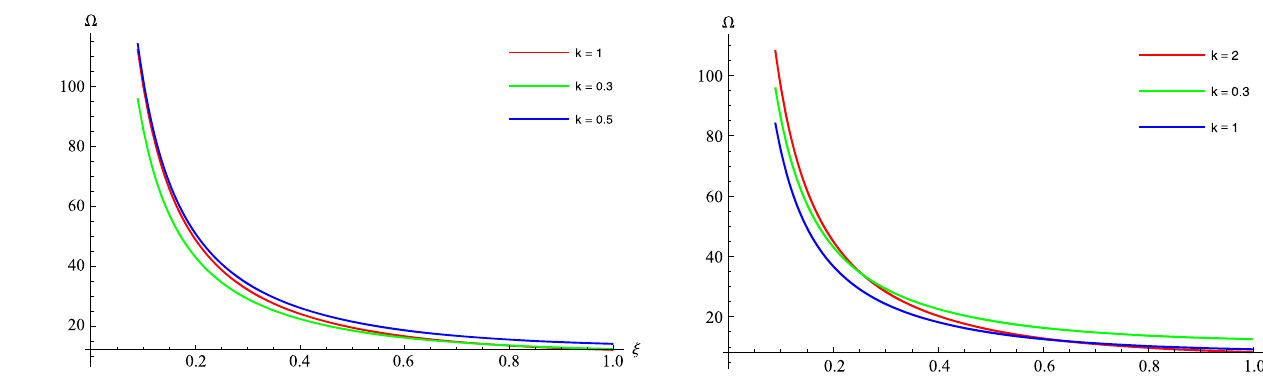
Fig. 2 Graphical representation of (cid:19) for case 2